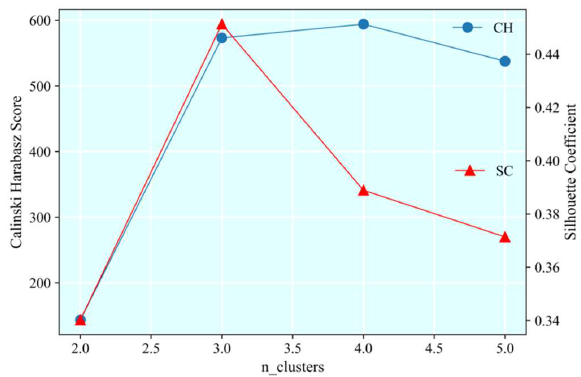
Figure 10. Silhouette coefficients and Calinski–Harabasz Score.